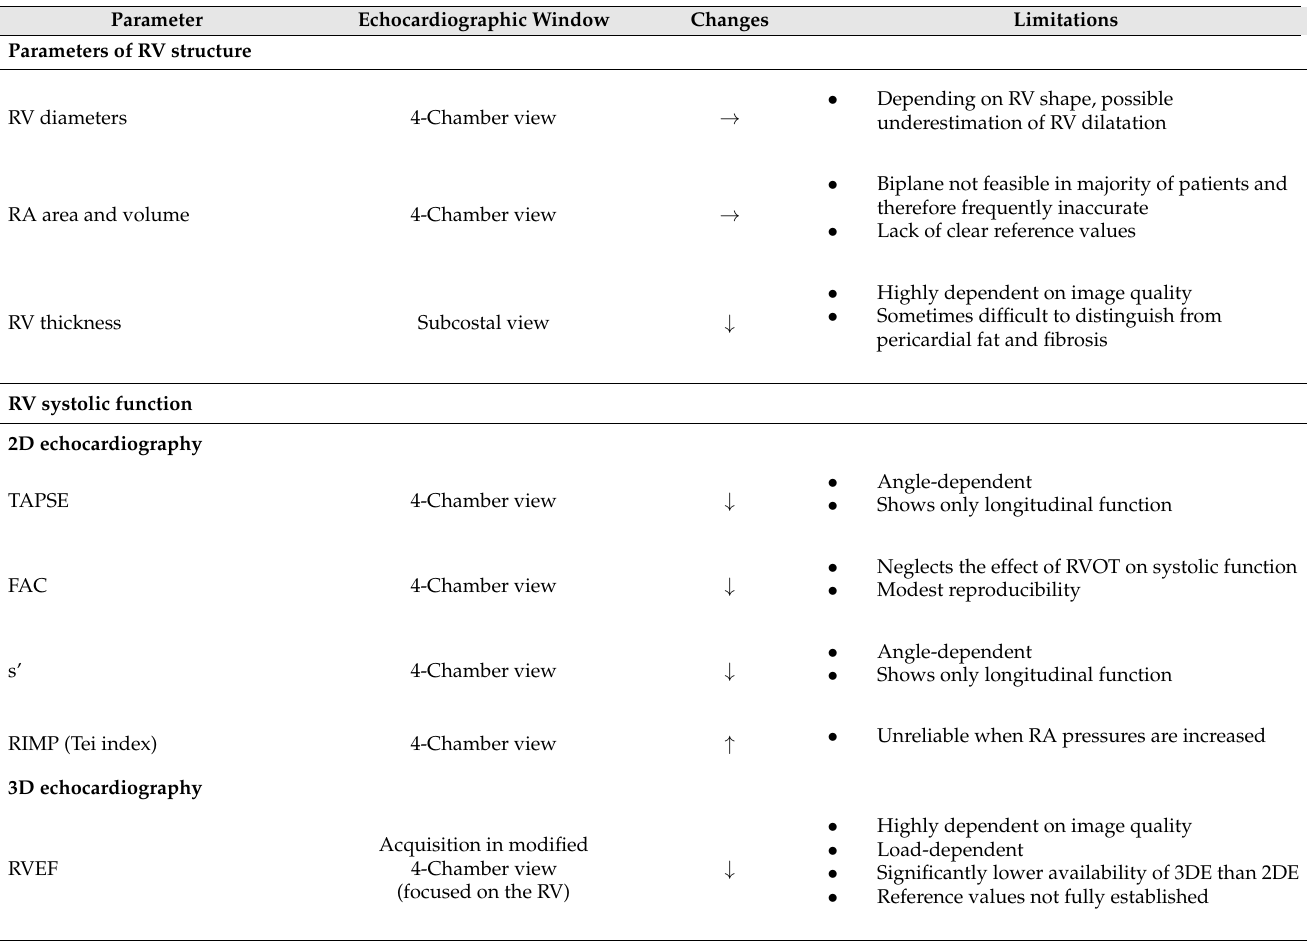
Table 4. Echocardiographic parameters used for evaluation of RV